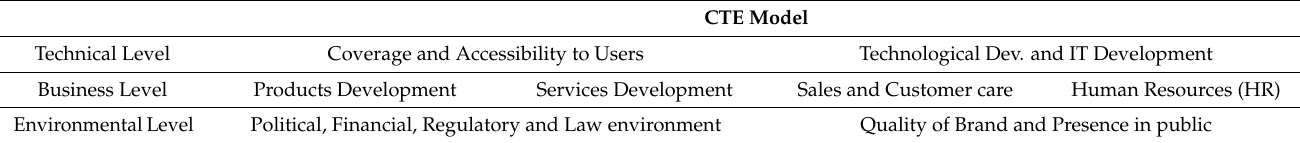
Table 1. The distribution of fields in the CTE